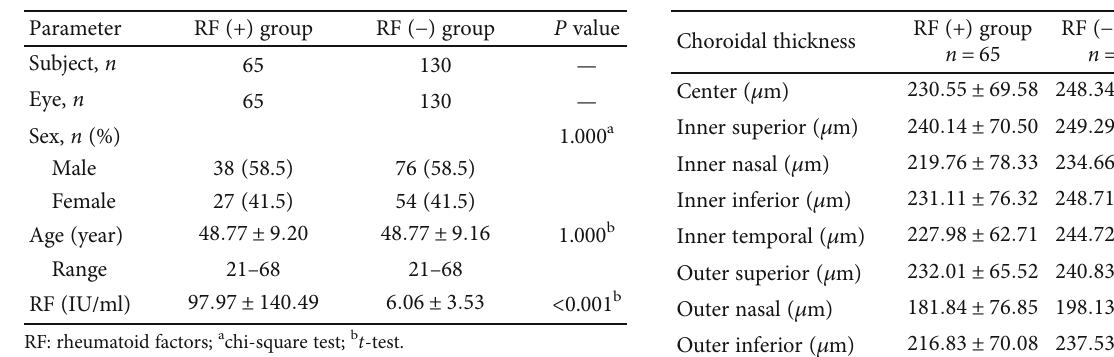
Table 1: Demographic characteristics.